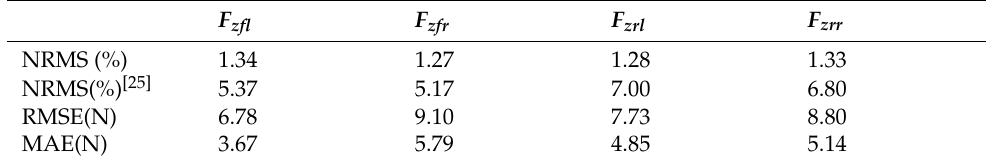
Table 7. The vertical force estimation